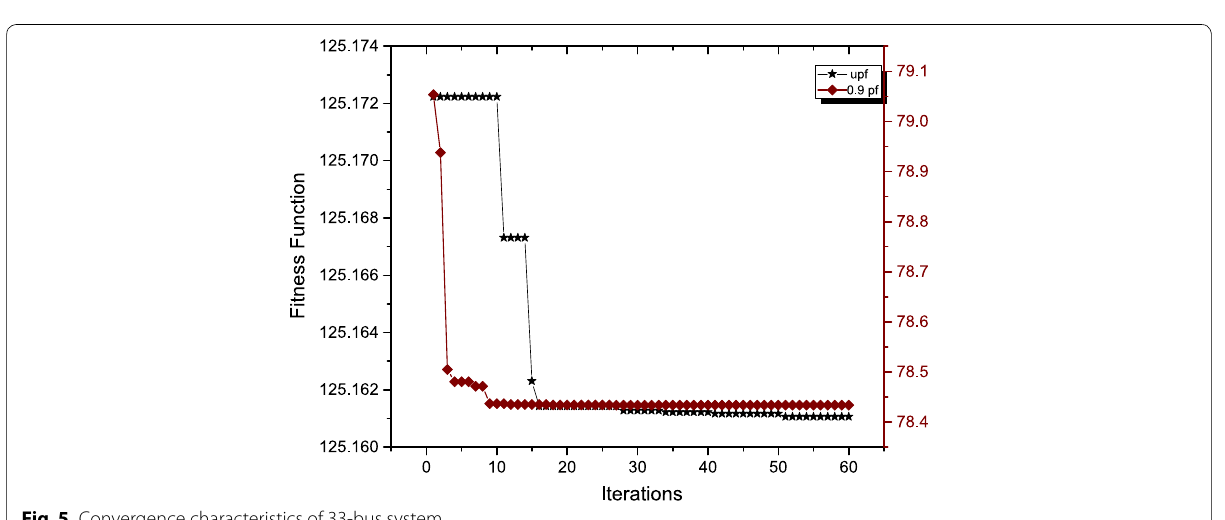
Fig. 5 Convergence characteristics of 33-bus